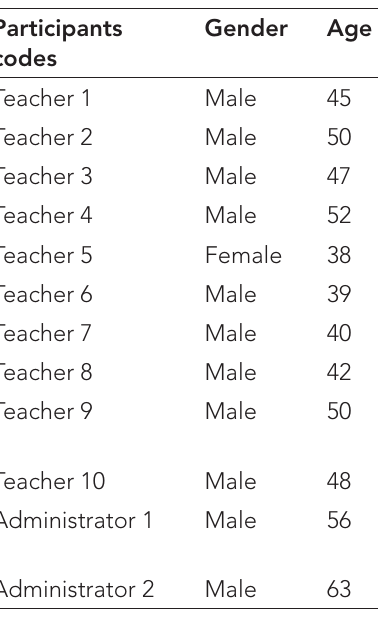
Table 1: Study participants’ profiles